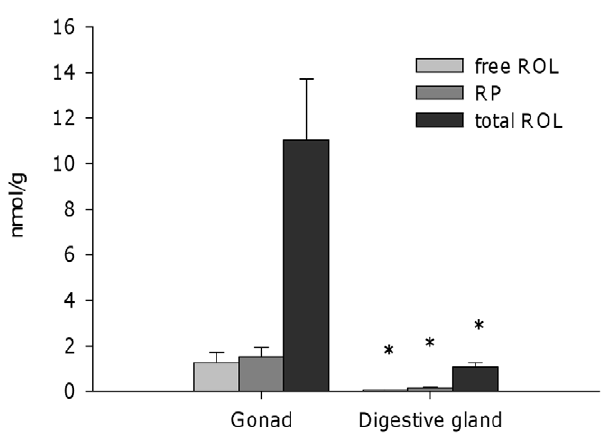
Figure 4. Distribution of retinoids within digestive gland- gonad complex in male Osilinus lineatus . Free retinol, retinyl palmitate and total (free + esterified) retinol distribution within mature (stage IV-V) male O. lineatus digestive gland-gonad complex. Values represent mean 6 SEM (n=3). Asterisks indicate significant differences with respect to levels in gonad (P , 0.05, Student’s t -test).